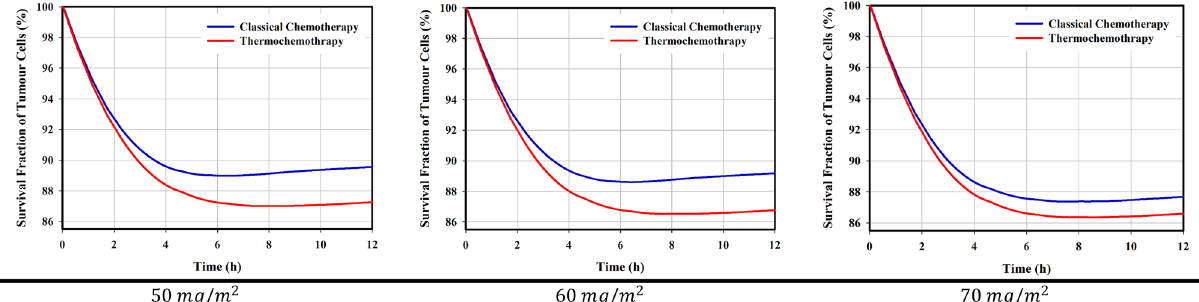
Figure 3. Cell mortality over time; In general, increasing the injected dose enhances the cell-death rate. Additionally, by applying mild hyperthermia due to the increase in transmembrane rate, the cell nucleus